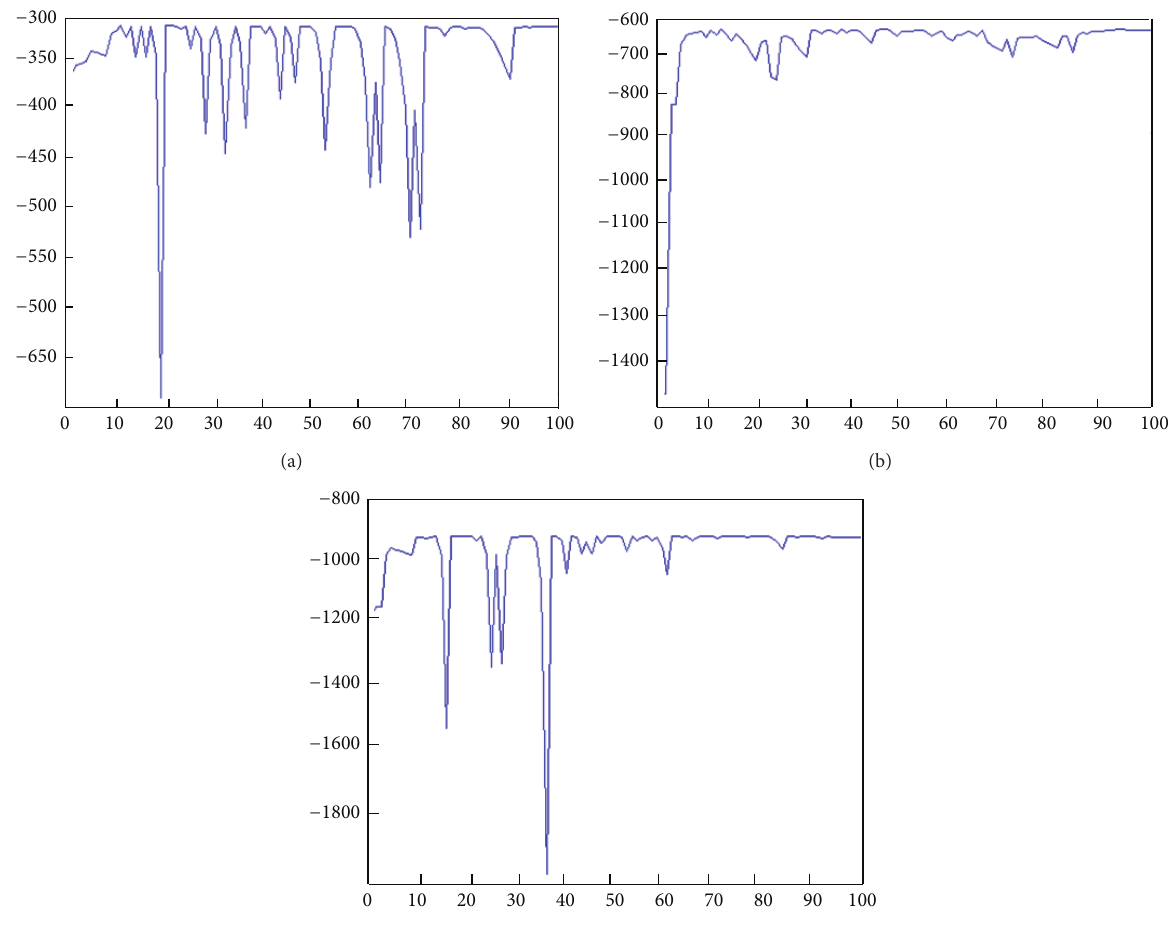
Figure 2: Ln 𝐿(𝑏, 𝛽,𝑠) versus iteration counter for Example 1: (a) 𝑛 = 100 , (b) 𝑛 = 200 , and (c) 𝑛 = 300 .